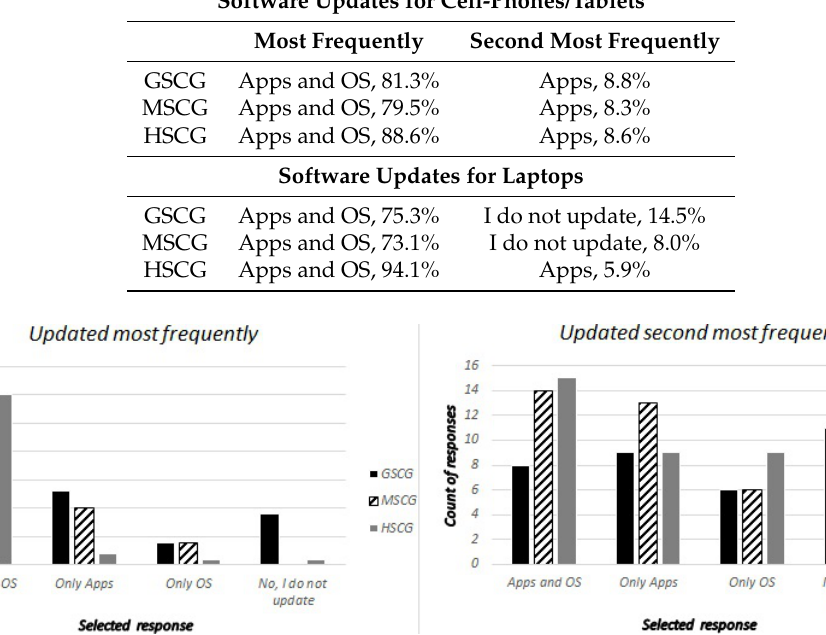
Figure 2. Expert predictions for question 2—cell-phone/tablets.